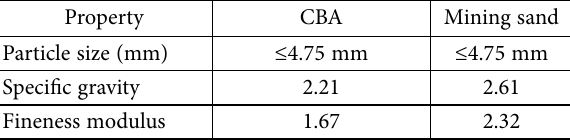
Table 3. Physical properties of CBA and mining